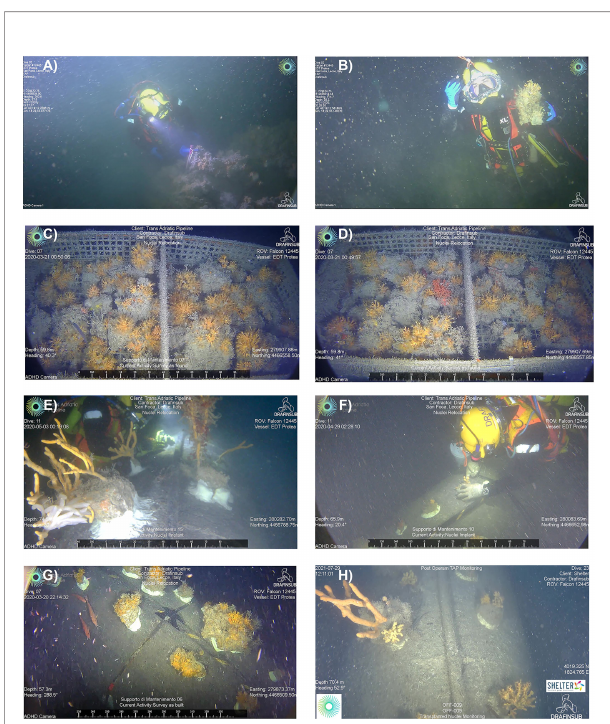
FIGURE 6 | Photo-table showing the three different phases of the removal and relocation intervention, and the following monitoring: (A, B) saturation divers removed nuclei from the interfered outcrops; (C, D) the nuclei were temporarily placed on the iron grid tables; (E, F) saturation divers relocated the nuclei on the top of the pipeline by using epoxy resin on concrete coatings; (G, H) images acquired during monitoring